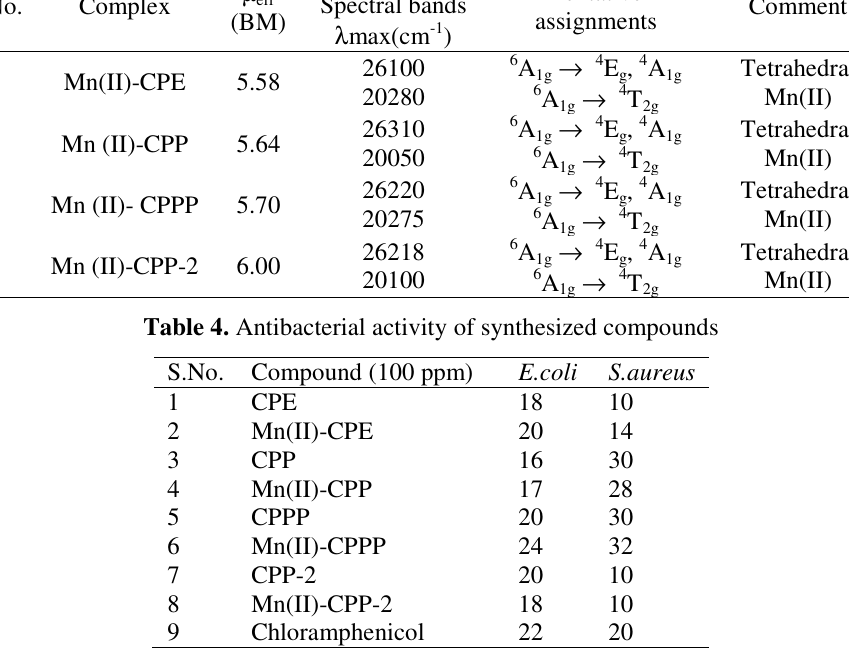
Tentative Comment assignments